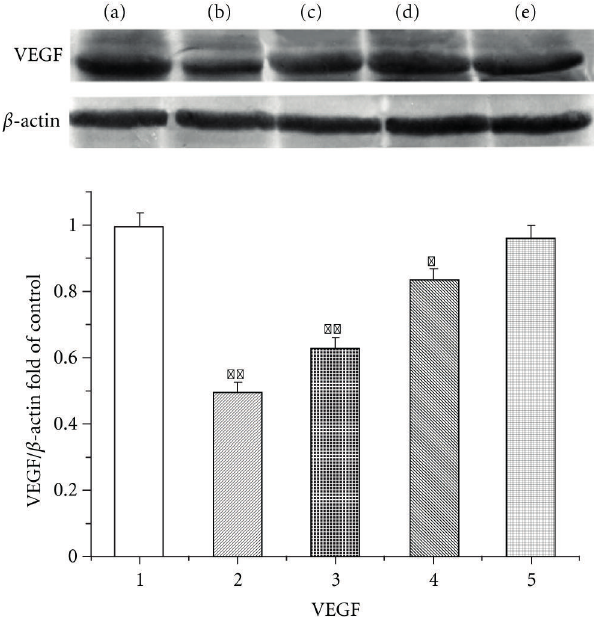
Figure 3: E ff ects of GCPs on the expression of VEGF protein in the tumor tissue. Lane (a): control; Lane (b): ADR (2mg/kg); Lane (c): GCPs (80mg/kg); Lane (d): GCPs (40mg/kg); Lane (e): GCPs (20mg/kg). ∗ P < 0 . 05, ∗∗ P < 0 . 01 versus Control; # P < 0 . 01 versus